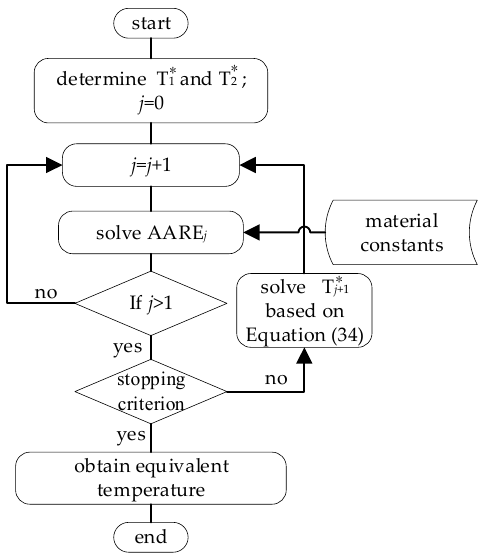
Figure 9. Process of solving a single equivalent temperature in the msA-type equation by combining multiple regression analysis with a linear search.